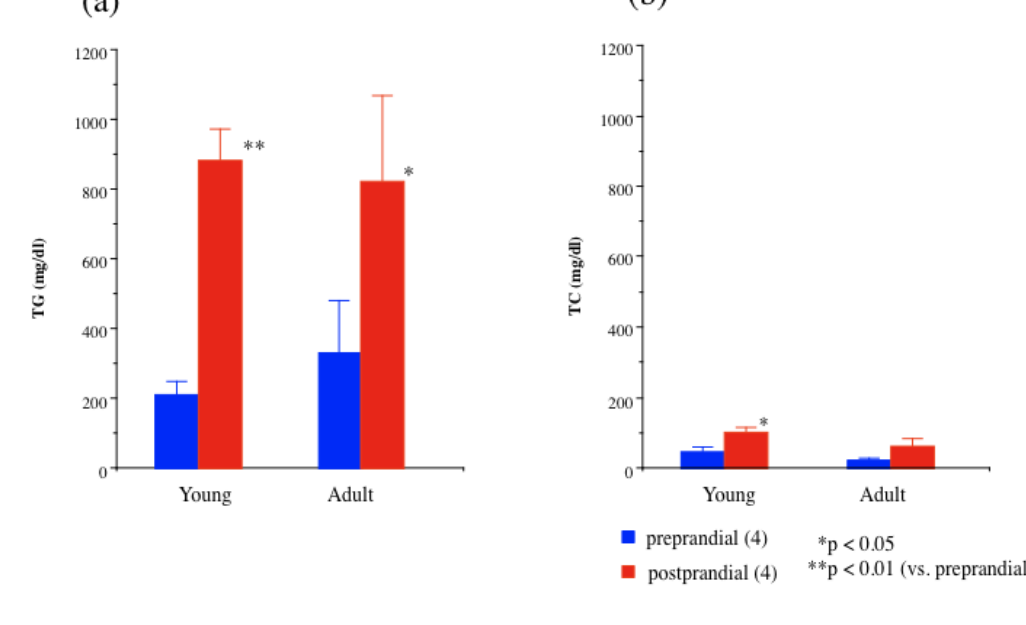
Figure 3. Plasma lipid concentrations in young and adult 33-months-old PHT rabbits before (preprandial; blue columns) and 18 h after feeding (postprandial; red columns). ( a ) Triglyceride (TG); ( b ) Total cholesterol (TC). Number of animals in